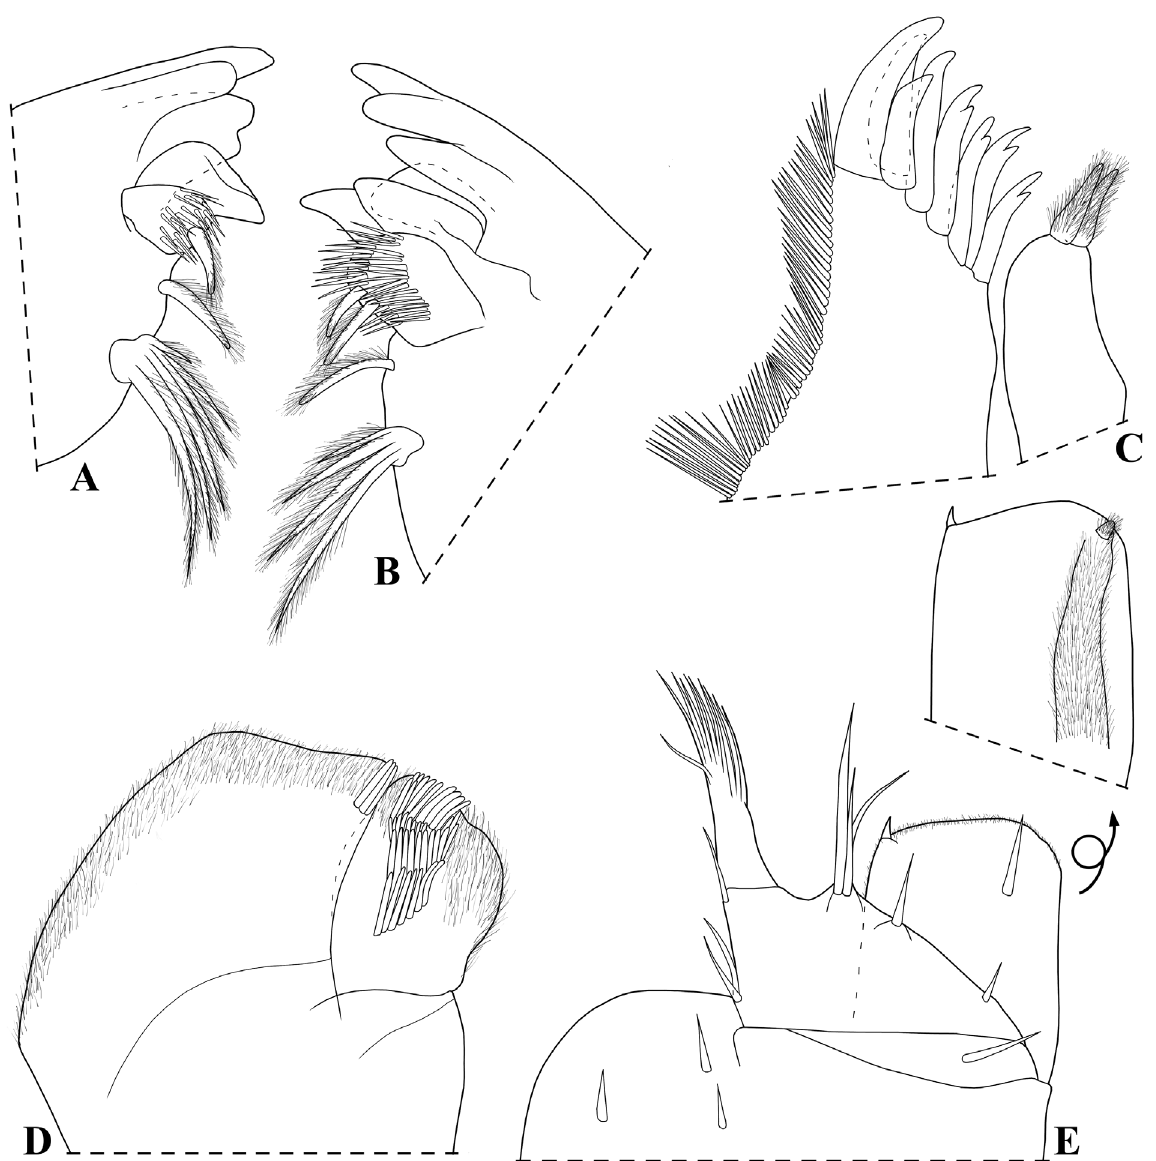
Fig. 6. Androdeloscia akuanduba Campos-Filho, Cardoso & Taiti sp. nov., ♀, paratype (MZUSP 39671). A . Right mandible. B . Left mandible. C . Maxillula. D . Maxilla. E .